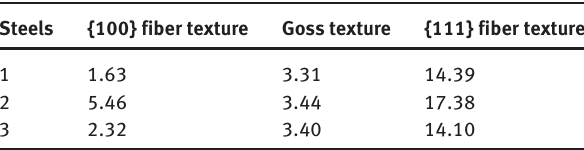
Table 3: The volume fractions of three fiber texture components of annealed cold-rolled steel sheets (%)